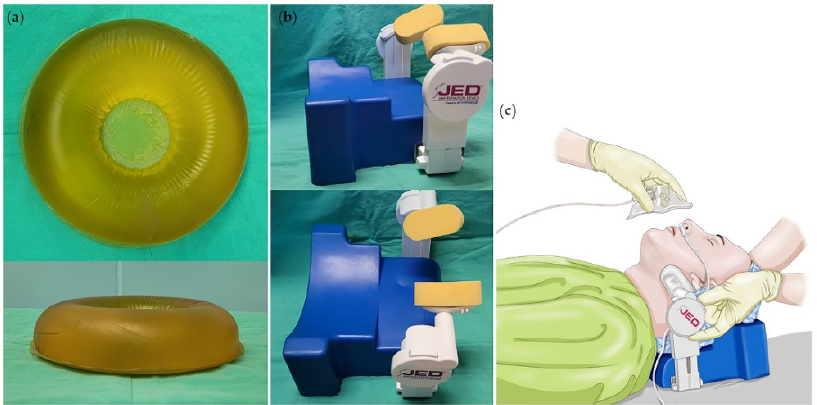
Figure 1. ( a ) Doughnut head gel pad ( b ) Jaw elevation device (JED) ( c ) portable polysomnography nasal cannula applied at the nares and facial mask on top.